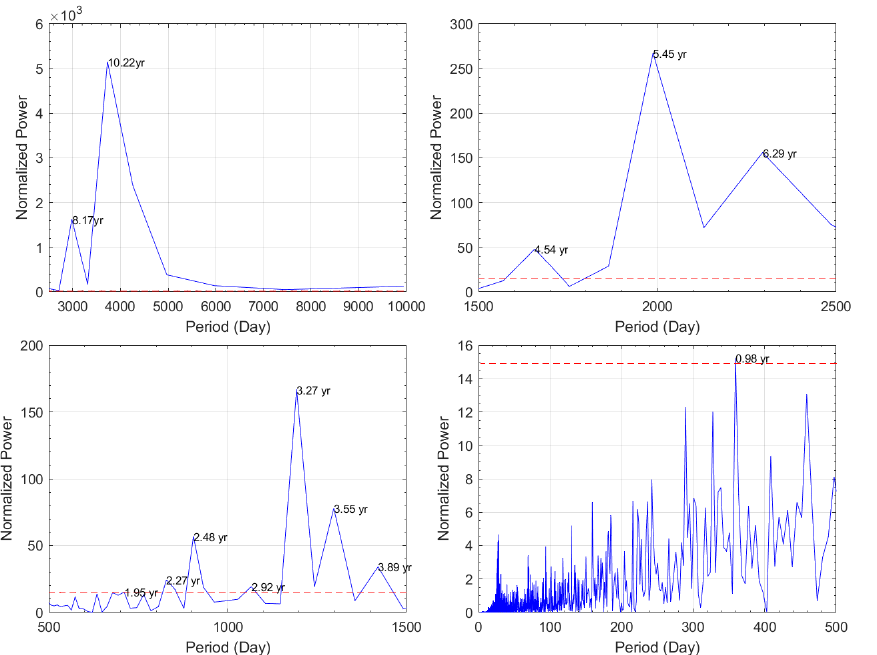
Figure 2. Lomb–Scargle periodogram of the modified coronal index. The red dashed lines are the 99% significant level. ( Upper left panel ): periods from 2500–10,000 days; ( Upper right panel ): periods from 1500–2500 days; ( Lower left panel ): periods from 500–1500 days; ( Lower right panel ): periods from 2–500